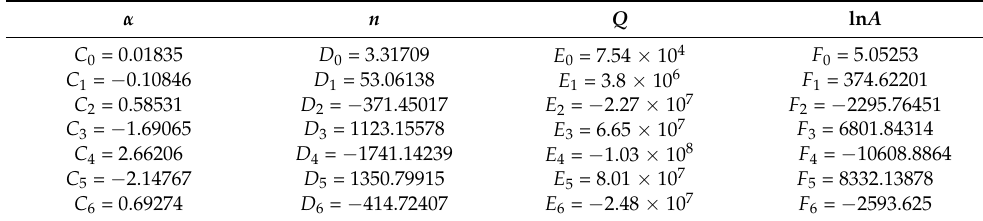
Table 5. Coefficients of the polynomial for α , n , Q and ln A